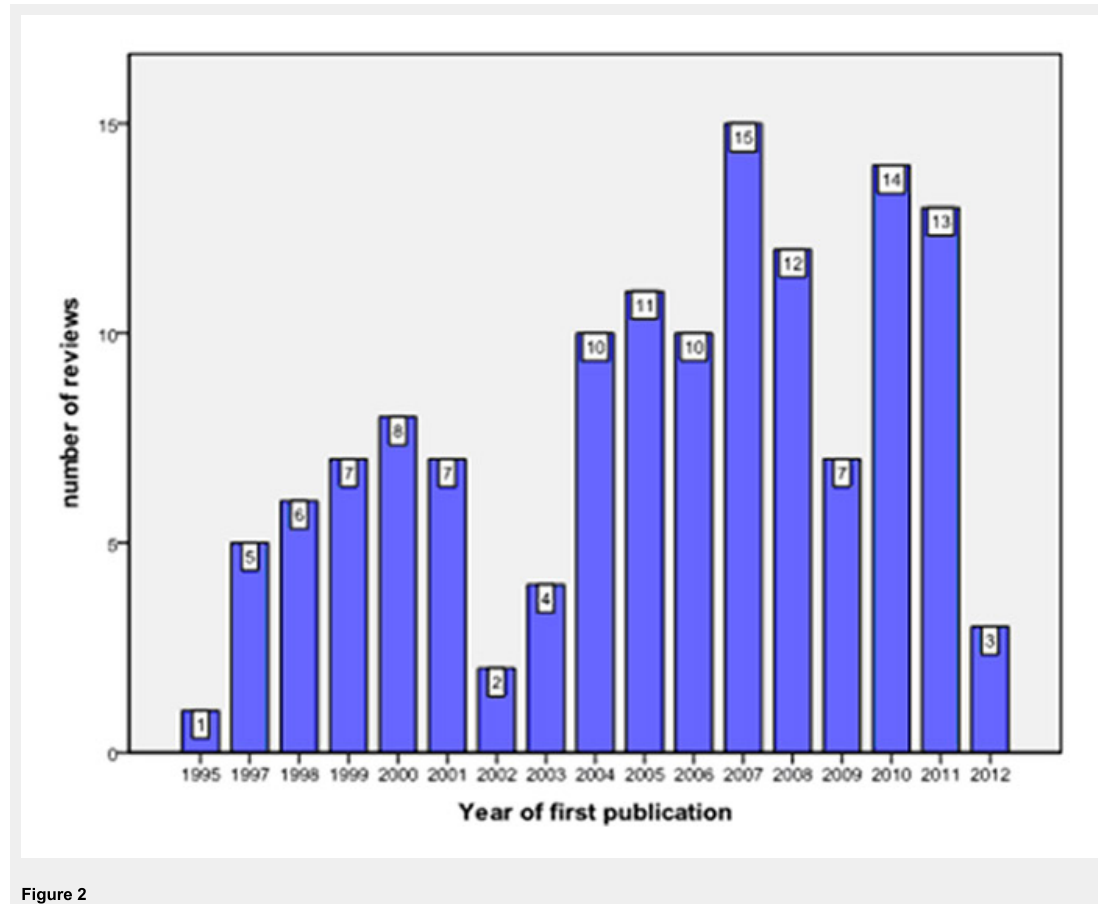
Figure 2 Number of Cochrane reviews published between 1995 and